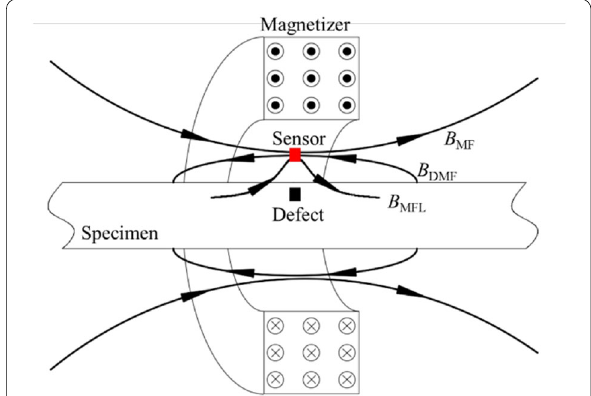
Figure 5 Measuring principle in the MFL testing